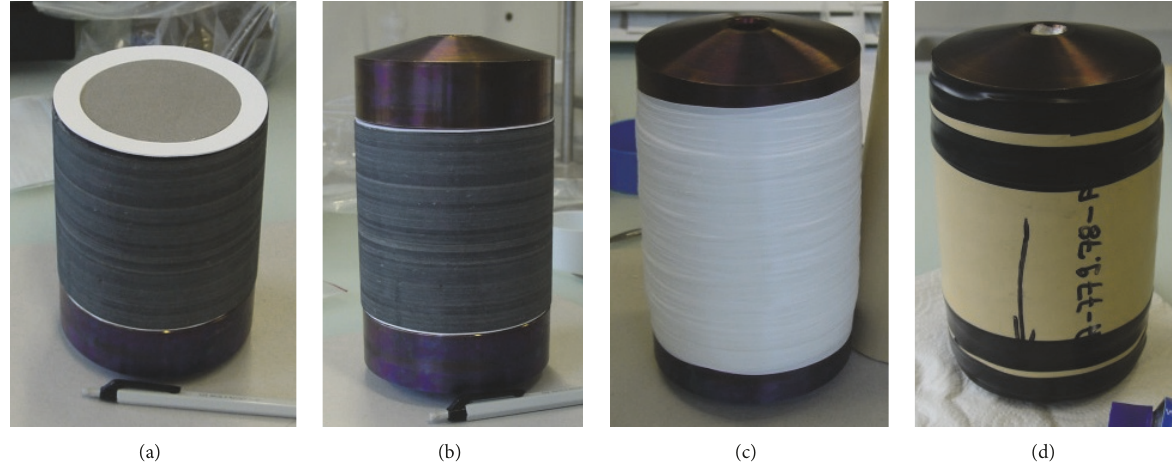
Figure 3: Stages of sample preparation: (a) rock core with porous filters at top and base, (b) placed between titanium couplings, (c) wrapped with Teflon tape, and (d) covered with latex sleeve. See text for